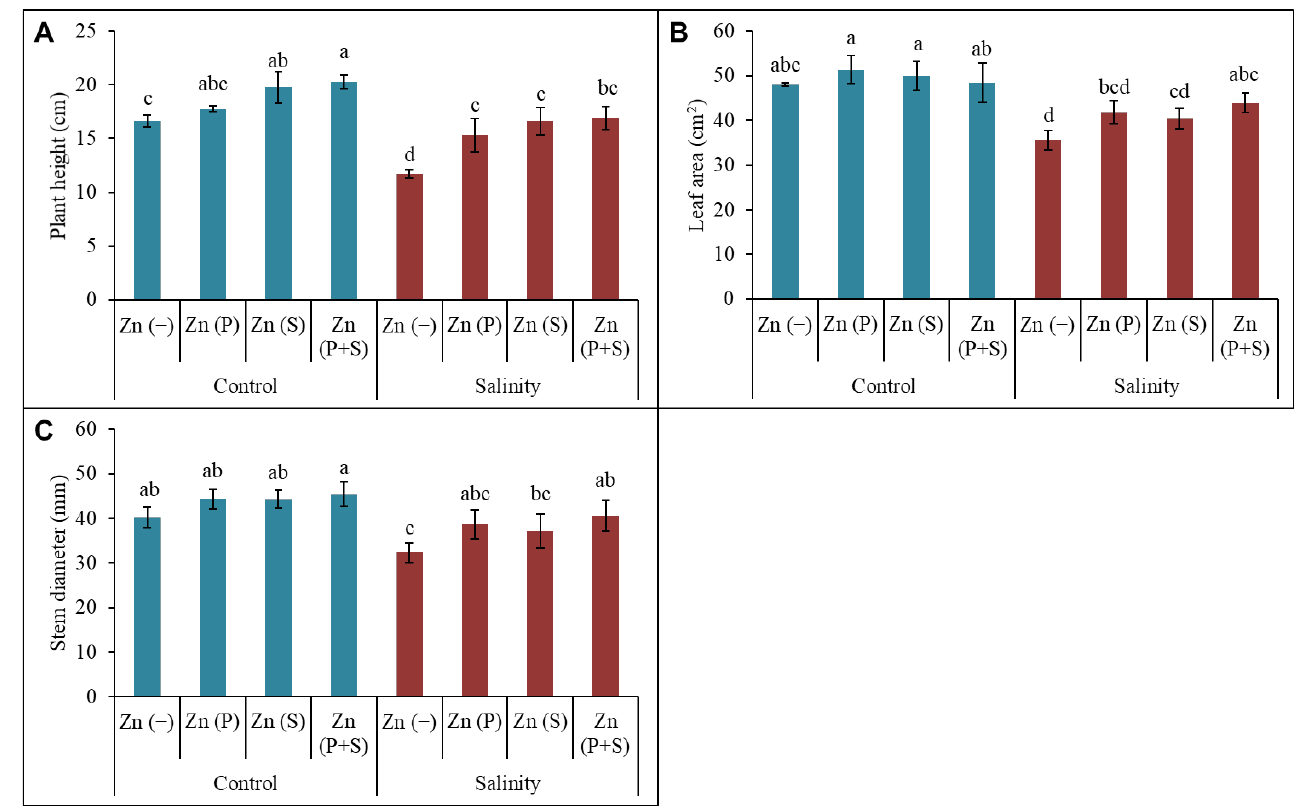
Figure 1. Plant height ( A ), leaf area ( B ) and stem diameter ( C ) of soybean plants induced by Zn supplementation. Twenty five-day-old plants were subjected to salt (150 mM NaCl) and supple- mented with Zn (1 mM ZnSO 4 · 7H 2 O). P and S indicate seed priming and foliar application with Zn, respectively. Control treatments were grown with water. Mean ( ± SD) was calculated from three replicates for each treatment. Different letters of bars indicate significant differences at p ≤ 0.05 ap- plying Tukey’s HSD test.